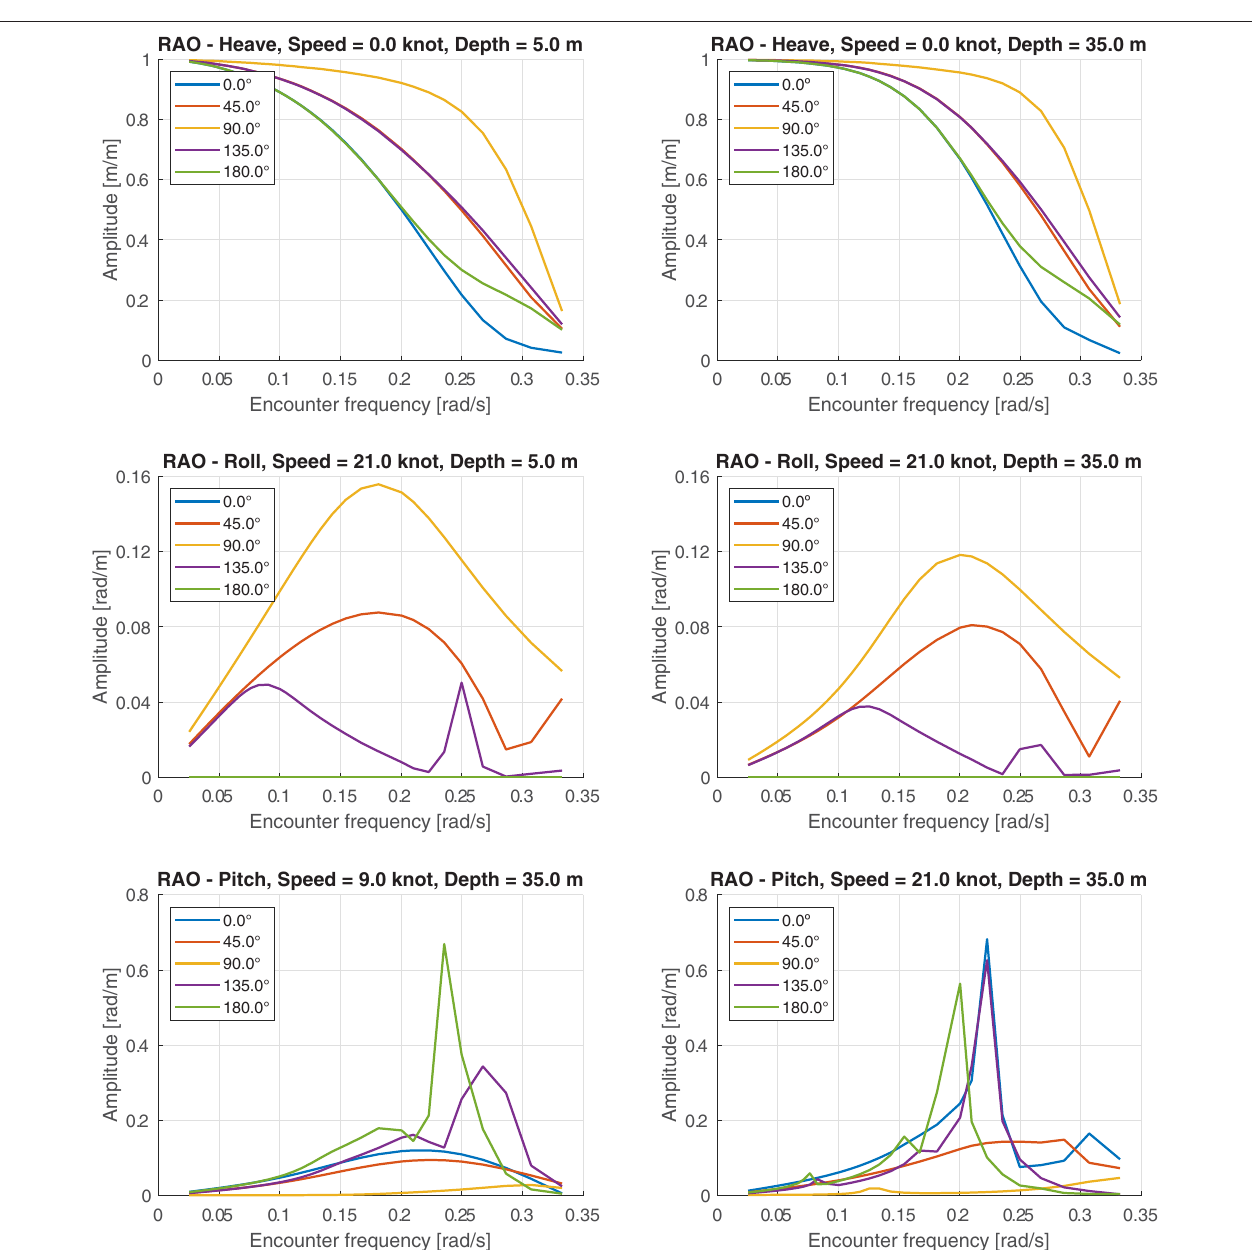
FIGURE 6 | Response Amplitude Operator (RAO) for heave, roll and pitch of the employed CTV. The subplots give an overview of the sensitivity of RAOs to vessel speed, vessel heading, water depth, and encounter frequency.